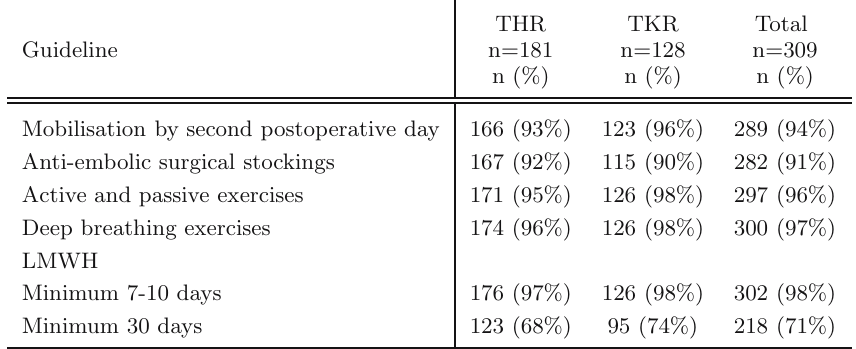
Table 7 Compliance to Clinical Guidelines [24] for prevention of deep vein thrombosis (DVT) for total hip (THR) and knee (TKR) replacement